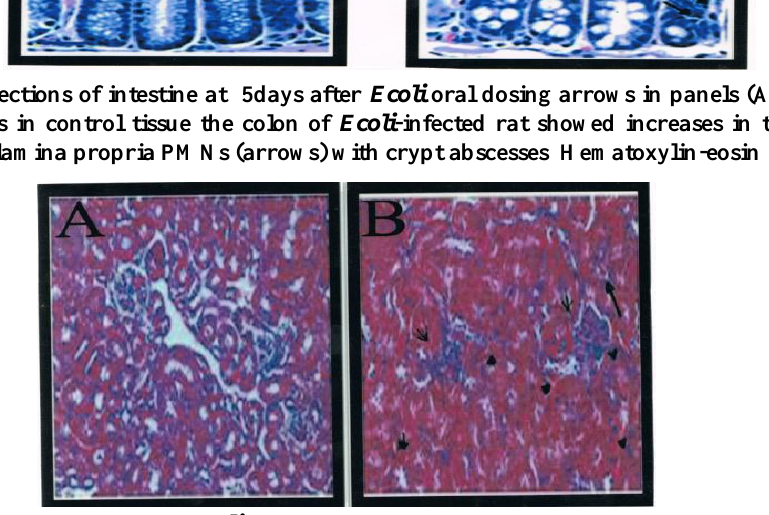
Figure – 2 – sections of kidney Ecoli – infected rat The renal cortex contained microthrombi (small arrows) and interstitial hemorrhages (small arrowheads) and glomeruli were congested (open arrowheads) (B)capillary lumina were frequently obstructed Renal tubular epithelial cells were also swollen with diminished lumen diameter and many were undergoing necrotic change (B) Hematoxylin-eosin (HE) (X40).